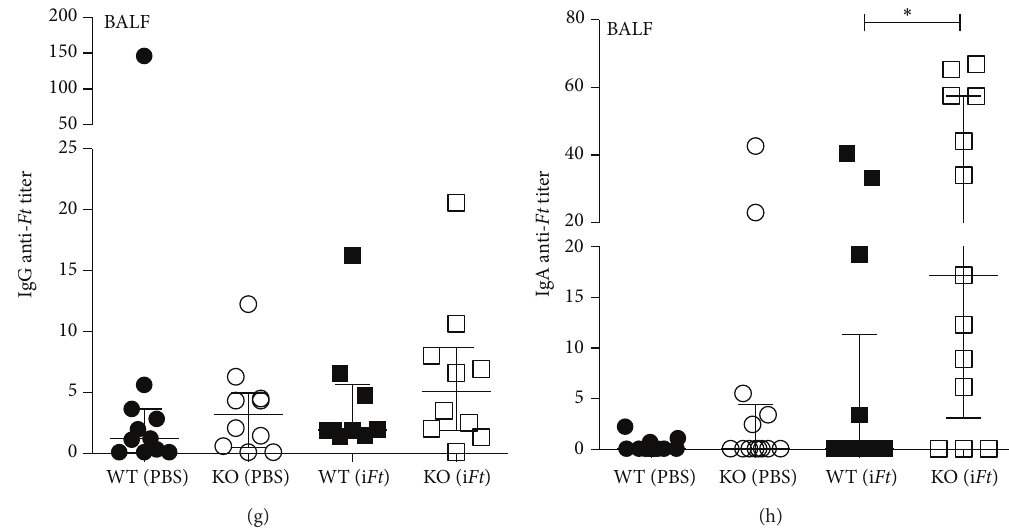
Figure 2: Ft -specific IgA, but not IgG, is significantly increased in Fc 𝛾 RIIB KO versus WT mice following i Ft -immunization. Fc 𝛾 RIIB KO and WT mice were immunized i.n. with 20 𝜇 L of PBS (vehicle) or 2 × 10 7 i Ft- organisms in 20 𝜇 L of PBS on day 0 and boosted on day 21. Serum was then collected on day 35 and levels of total Ft -specific Ab (a), Ft -specific IgG (b), Ft -specific IgG2c (c), Ft -specific IgG1 (d), Ft -specific IgM (e), and Ft -specific IgA (f) were determined via ELISA. Titers of Ft -specific IgG (g) and Ft -specific IgA (h) in BALF were similarly determined. Each symbol represents a single mouse. The 50% maximum of the highest experimental OD was determined and all experimental OD values were transformed to their respective log values. A log (agonist) versus response-variable slope (four parameters) nonlinear regression (curve fit) was performed on the log values, and the unknowns were interpolated. The inverse log was taken on the interpolated unknowns to determine the final titers for each individual mouse sample (error bars represent median with interquartile range of data distribution). Statistics were performed by adding 0.1 to the determined titer value and taking the log of this new value to correct for heteroscedasticity. A one-way ANOVA along with a Tukey’s multiple comparison test was performed, and median and interquartile range is graphed. ∗∗∗ 𝑃 < 0.001 ; ∗ 𝑃 < 0.05